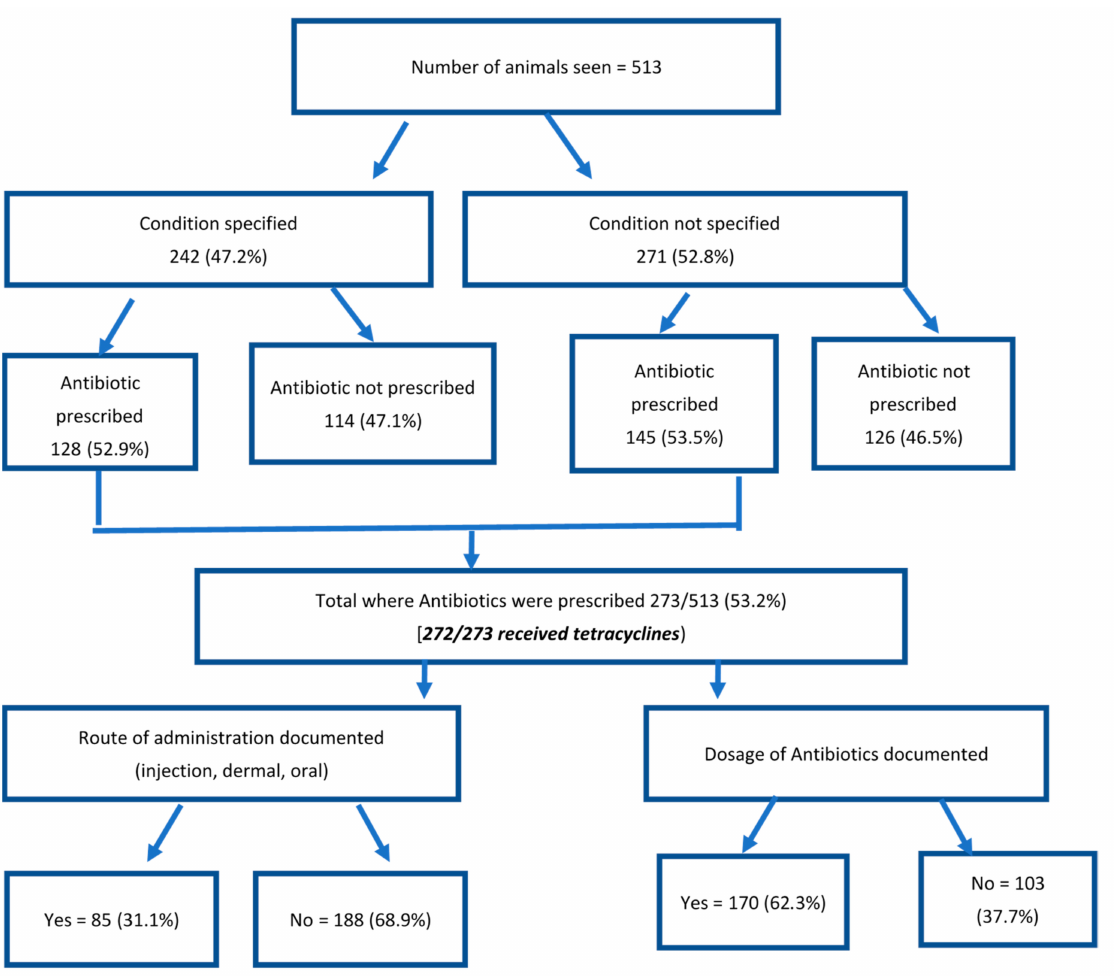
Figure 4. Flow chart depicting the specification of disease conditions and the documentation of antibiotics dosage and route of administration in the Kintampo Municipal Veterinary Clinic in Ghana, from